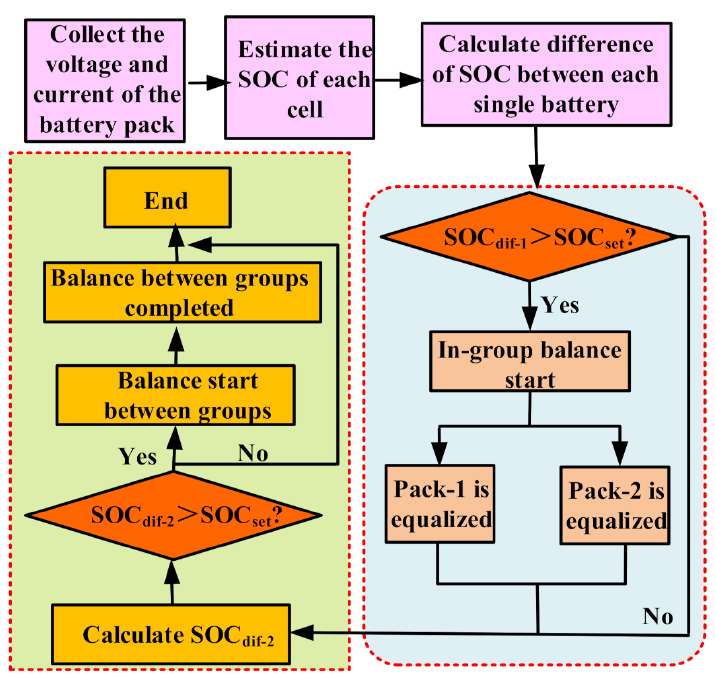
Figure 8. Flowchart for the battery pack equalization strategy. As shown in Equations (6) and (7), where SOC i and SOC n represent the SOC values of two different battery cells, respectively, SOC dif-1 refers to the SOC difference between two batteries and SOC dif-2 characterizes the difference between the battery